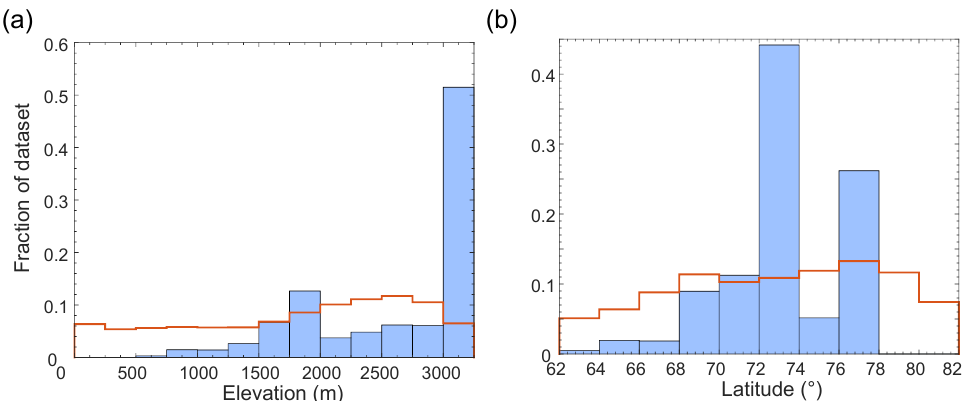
Figure 8. (a) Histogram showing the fraction of density subdataset by elevation. Red line is the fraction of elevations for the entire GrIS from the CryoSat-2 DEM. (b) Histogram showing the fraction of density dataset by latitude. Red line is the fraction of latitudes for the entire GrIS.